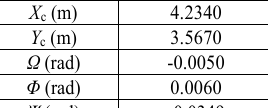
Figure 9. The point cloud of Pole 1captured by Velodyne HDL-32E (9a, left) and its projected cross section on the XY -plane (9b,